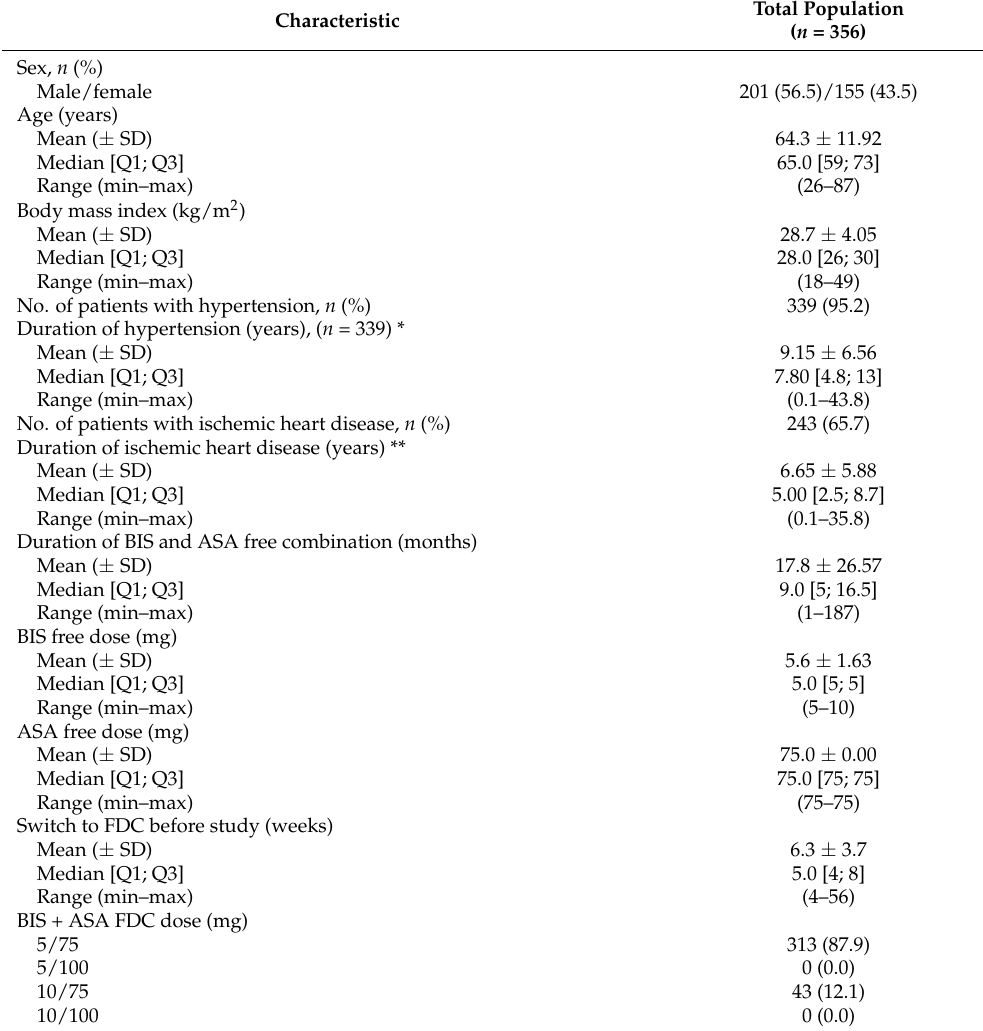
Table 1. Demographic and clinical characteristics of the study